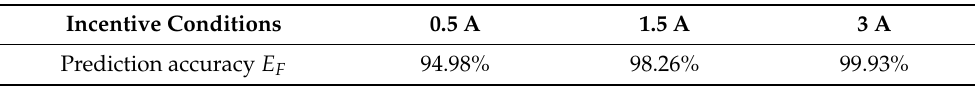
Figure 6. Curves of experimental and positive model identification results of mounting damping force and displacement under different currents. Table 1. Relative approximation accuracy of MR positive